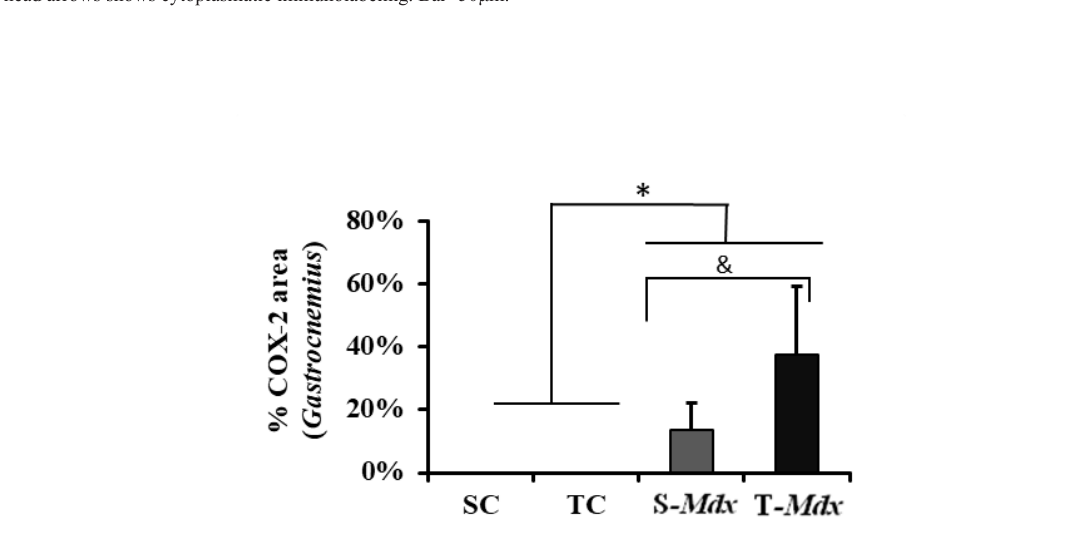
Figure - 6 Graph shows the percentage of COX-2 immunoreactive area (Mean + S.D) higher in Mdx groups than in C groups (*=p<0.05); and T-Mdx higher than S-Mdx group